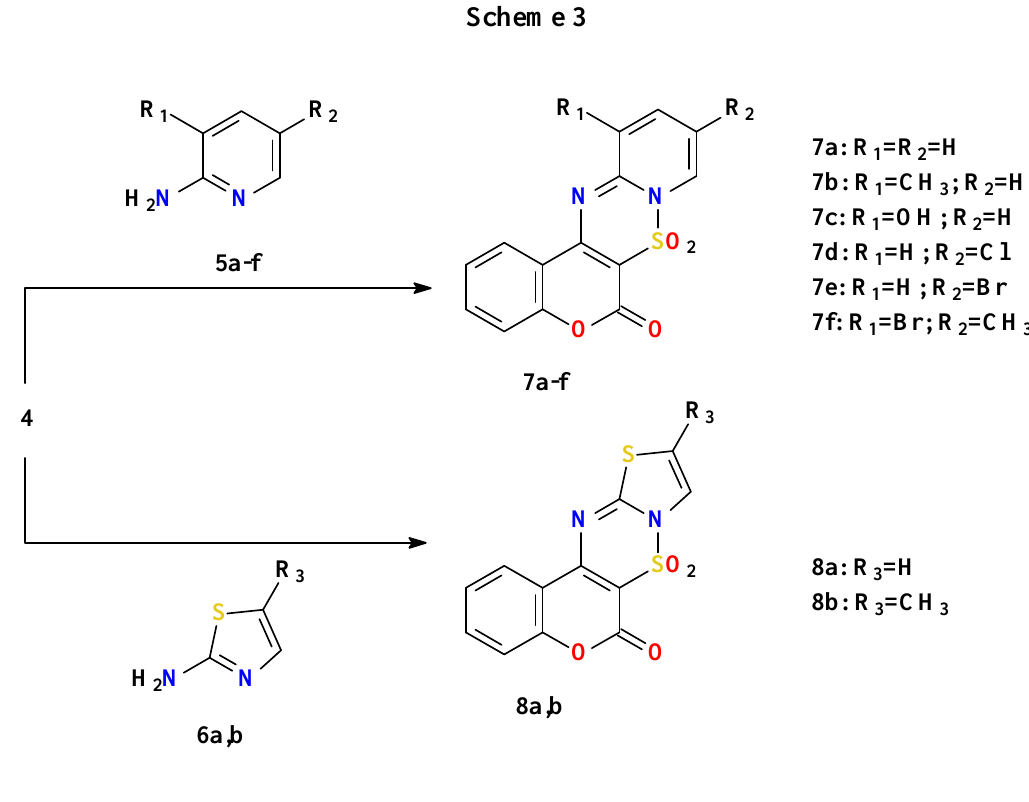
Figure 1. Diagram of compound 7a with the crystallographic numbering